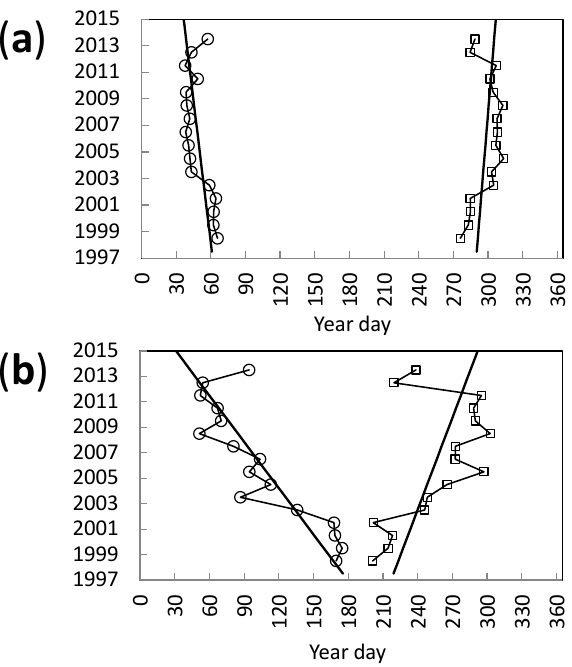
Figure 7. Temporal changes in the start and end of Ked490 = 0.1m − 1 (a) and Ked490 = 0.4m − 1 (b) for the central Baltic Sea (area indicated in Fig. 1b). The circles show the first day of the year (DFKED) and the squares show the last day of the year (DLKED) with the respective value of Ked490. The regression lines have been estimated for the time period of